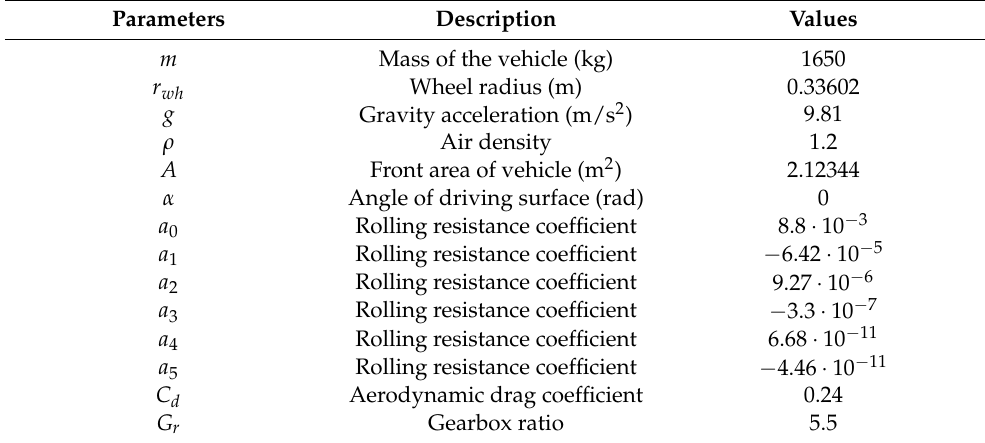
Table 1. Mechanical model parameters.